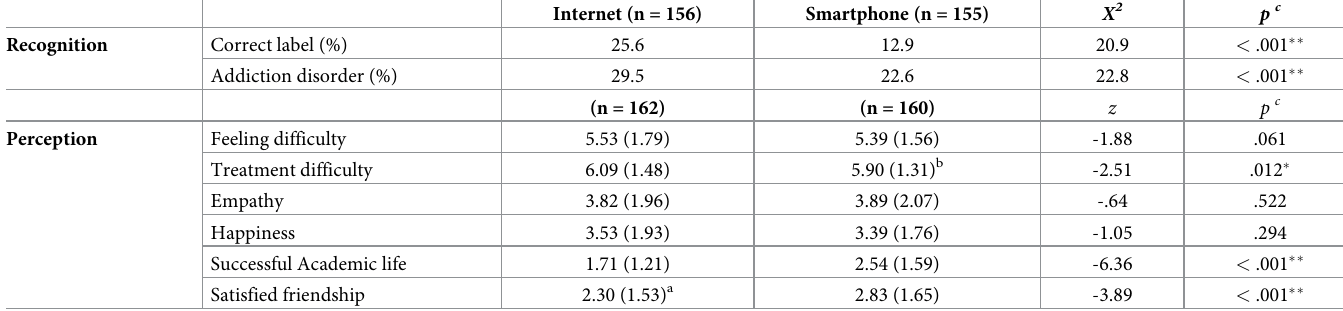
Table 2. Mean of the recognitions and ratings of the character adjustment to living with Internet and smartphone